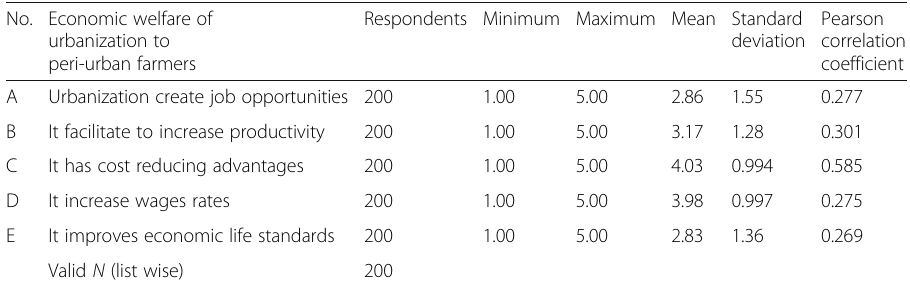
Table 5 Economic welfare of urbanization for peri-urban farmers No. Economic welfare of urbanization to